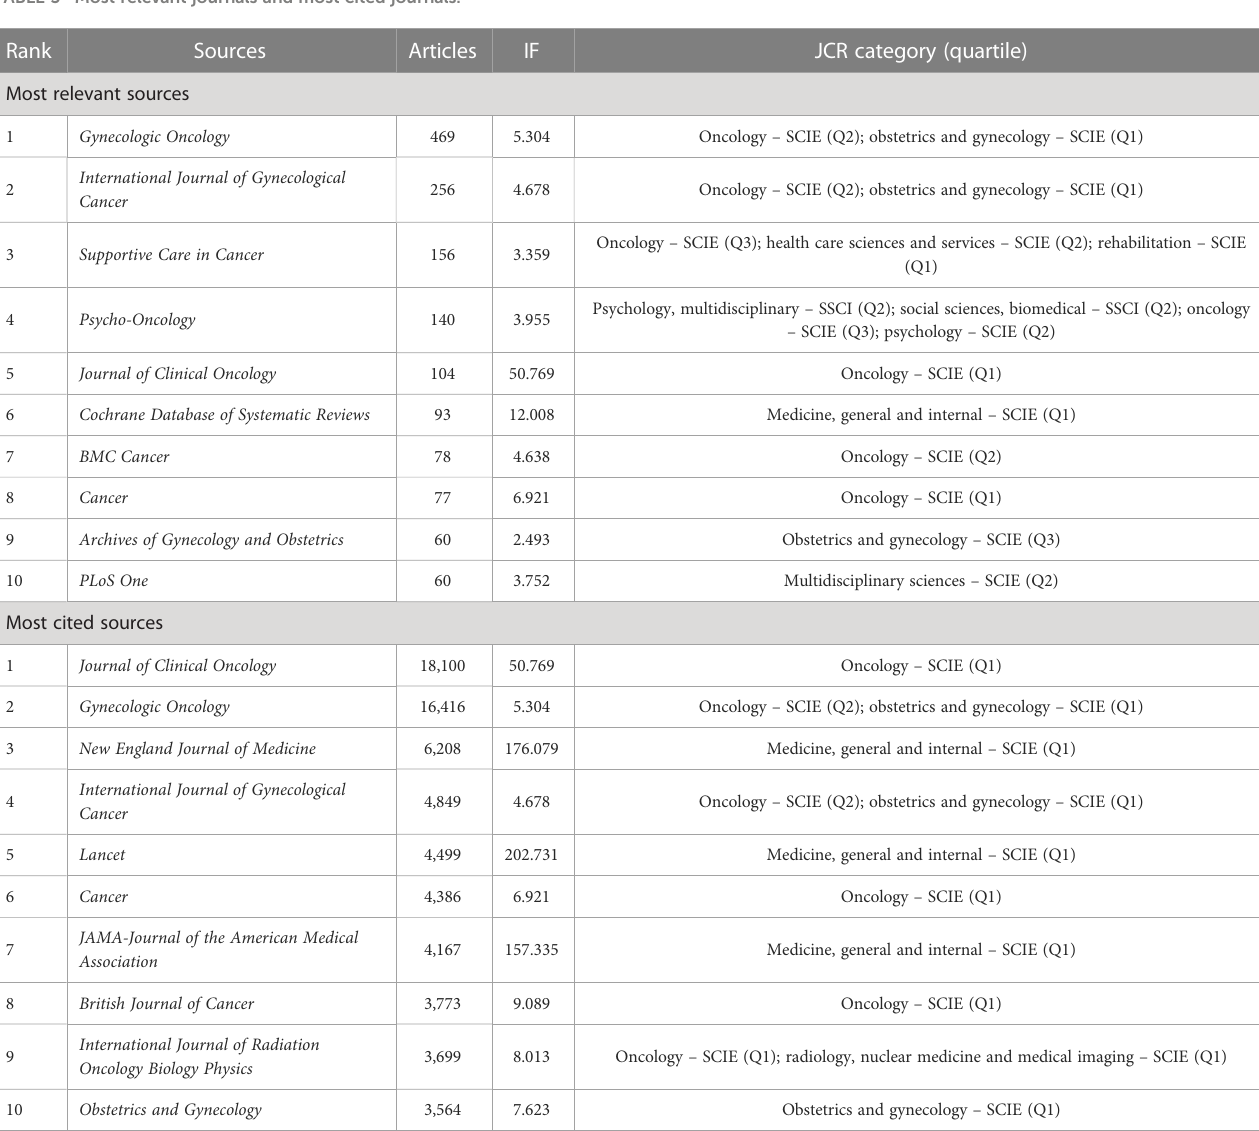
TABLE 3 Most relevant journals and most cited